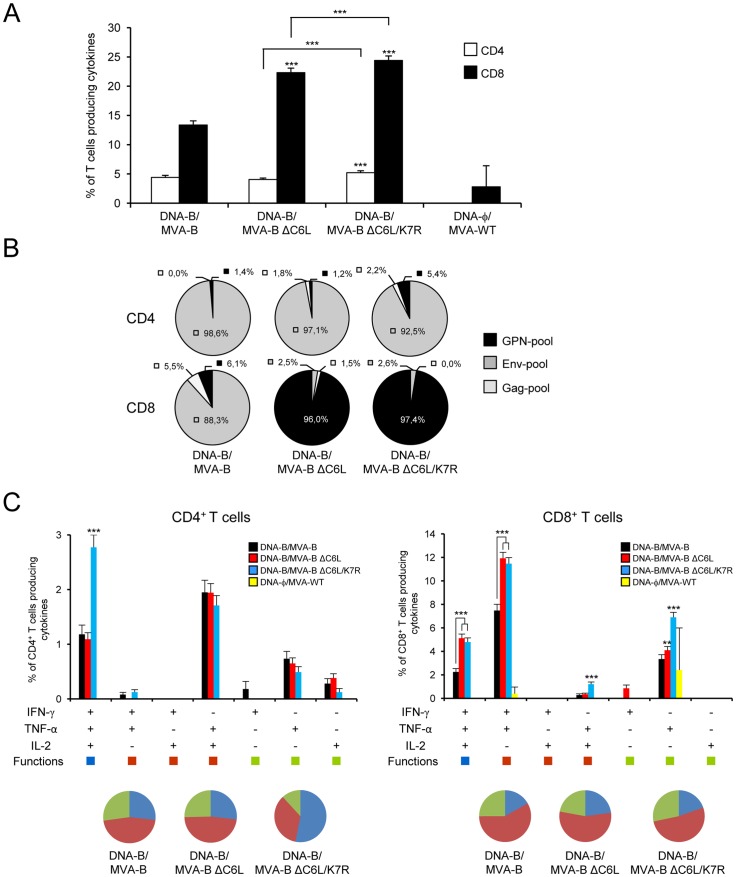
Immunization with MVA-B deletion mutants enhances the magnitude and polyfunctionality of HIV-1-specific CD4+ and CD8+ T cell adaptive immune responses.Splenocytes were collected from mice (n = 4 per group) immunized with DNA-φ/MVA-WT, DNA-B/MVA-B, DNA-B/MVA-B ΔC6L or DNA-B/MVA-B ΔC6L/K7R 10 days after the last immunization. Then, HIV-1-specific CD4+ and CD8+ T cell adaptive immune responses elicited by the different immunization groups were measured by ICS assay following stimulation of splenocytes with different HIV-1 peptide pools (Env-pool, Gag-pool and GPN-pool). Values from unstimulated controls were subtracted in all cases. p values indicate significantly higher responses compared to DNA-B/MVA-B immunization group, and also between MVA-B deletion mutants. Data are from one experiment representative of three experiments. (A) Magnitude of HIV-1-specific CD4+ and CD8+ T cells. The values represent the sum of the percentages of T cells secreting IFN-γ and/or TNF-α and/or IL-2 against Env+Gag+GPN peptide pools. *** p<0.001. (B) Percentage of Env, Gag and GPN HIV-1-specific CD4+ and CD8+ T cell adaptive immune responses. Frequencies were calculated by reporting the number of T cells producing IFN-γ and/or TNF-α and/or IL-2 to the total number of CD4+ and CD8+ T cells in the different immunization groups. (C) Polyfunctionality of HIV-1-specific CD4+ and CD8+ T cells. Functional profiles of HIV-1-specific CD4+ (left panel) and CD8+ (right panel) T cell adaptive immune responses in the different immunization groups. Responses are grouped and color-coded on the basis of the number of functions. All the possible combinations of the responses are shown on the X axis, while the percentages of T cells secreting IFN-γ and/or TNF-α and/or IL-2 against Env+Gag+GPN peptide pools are shown on the Y axis. The pie charts summarize the data. Each slice corresponds to the proportion of HIV-1-specific CD4+ or CD8+ T cells producing one, two or three cytokines (IFN-γ and/or TNF-α and/or IL-2) within the total HIV-1-specific CD4+ or CD8+ T cells. * p<0.05, ** p<0.005, *** p<0.001.